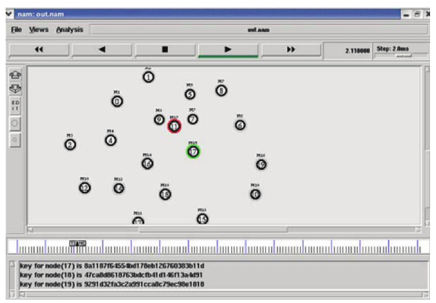
Figure 2: Simulation of identifying Sybil node.